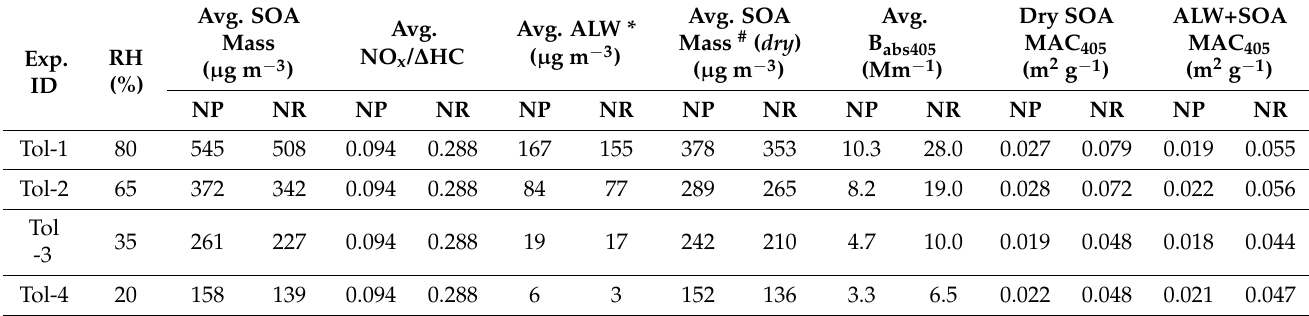
Table 3. SOA Properties under various experimental conditions in the NP and NR regimes.